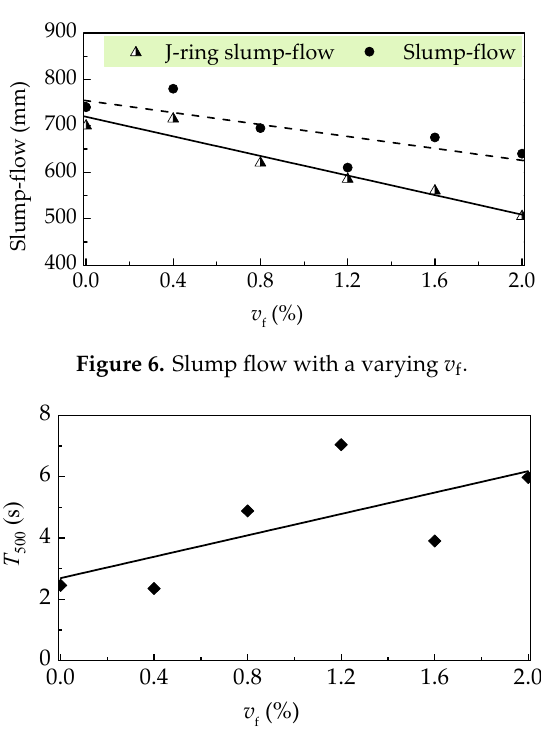
Figure 5. Tests for the workability of fresh self-compacting SFRELC: ( a ) testing device; ( b ) slump flow; ( c ) J-ring slump flow.